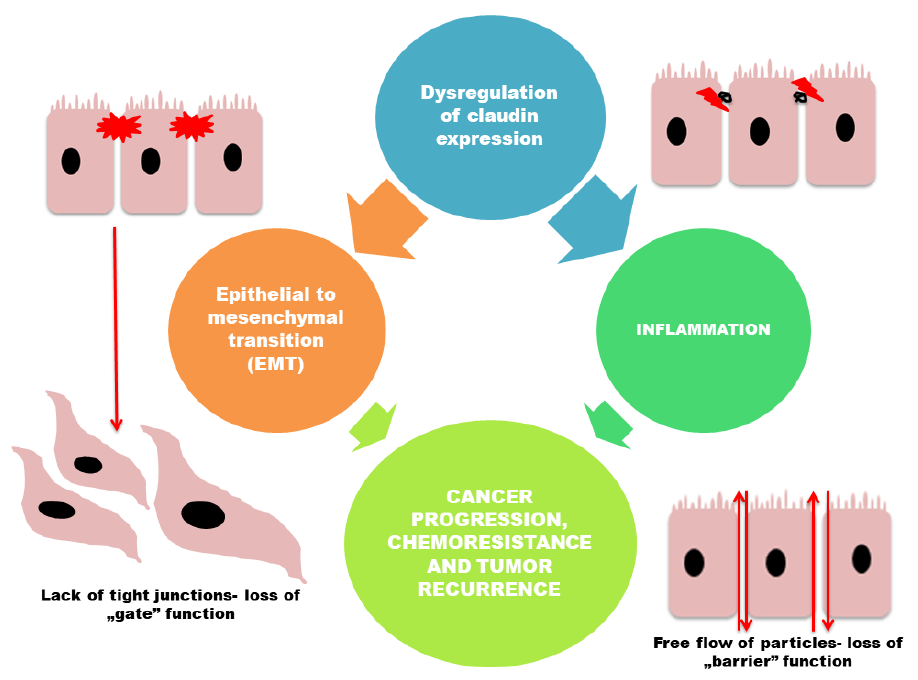
Figure 3. Diagram showing the involvement of claudins in cancer initiation and progression. Table 2. Summarized changes in claudin expression in hormone-related cancers in the human reproductive system.